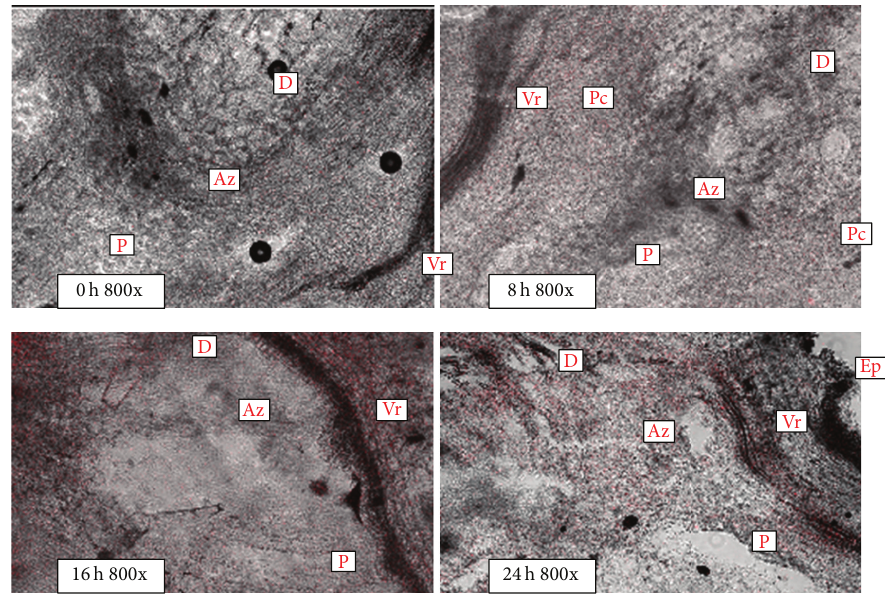
Figure 3: Immunolocalization of polygalacturonase (PG) in tomato pedicel with Cy3 fluorescent labeling. D, Az, and P indicate the distal, abscission zone, and proximal side, respectively. Pc: parenchyma cells; Ep: epidermis; Vr: vascular bundle region.